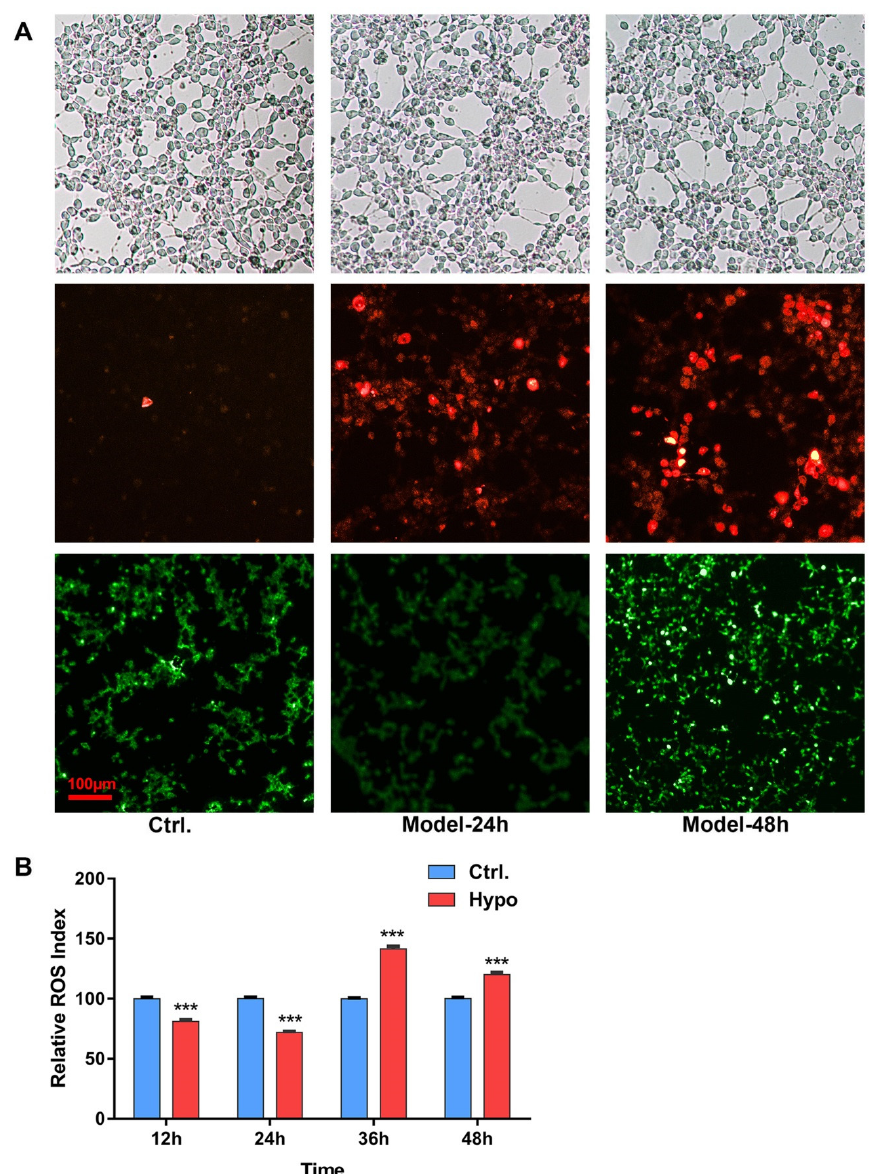
Figure 1. Relative ROS levels of RIN-14B Cells after hypoxia (5% O 2 ) treatment. ( A ) Cells were stained with, Dihydroethidium (DHE), DCFH-DA, and were observed under a fluorescence microscope. Representative fluorescence images showed the ROS levels in RIN-14B cells compared to control after exposure to 5% O 2 for 24 h/48 h. (Scale bar: 100 µ m). ( B ) ROS were detected every 12 h with ROS assay kit; every group set the normoxic (21% O 2 ) group as a control, ( n = 8 each group). *** P < 0.001 represent compared with each